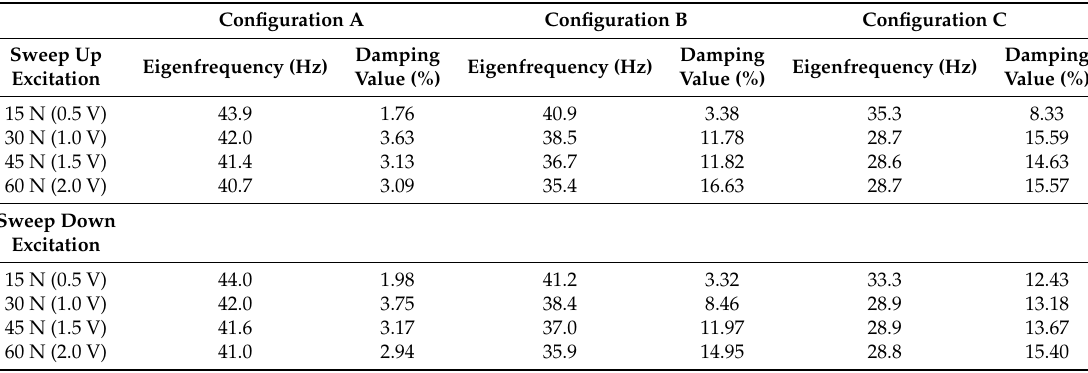
Table 3. Overview of the estimated modal parameters of configurations A–C for both sweep up and down excitation and this for all amplitude